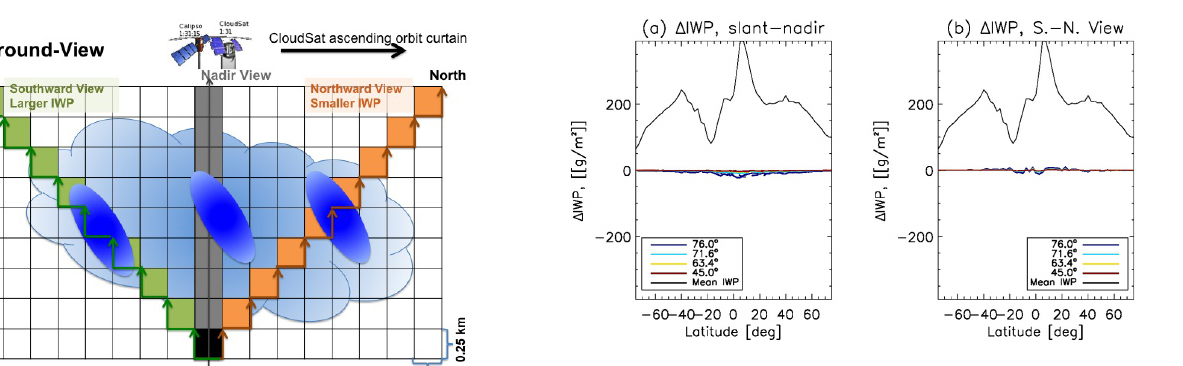
Figure 8. Ground-based view of (a) latitudinal distribution of JJA (cid:49) IWP between nadir and southward-looking view (solid lines), nadir and northward-looking views (dashed lines with the same color of solid lines). (b) Latitudinal distribution of JJA (cid:49) IWP be- tween southward-looking and northward-looking views (solid color lines) integrated from 5 to 19km. The black solid lines are the mean IWP at nadir. See Fig. 7 for viewing